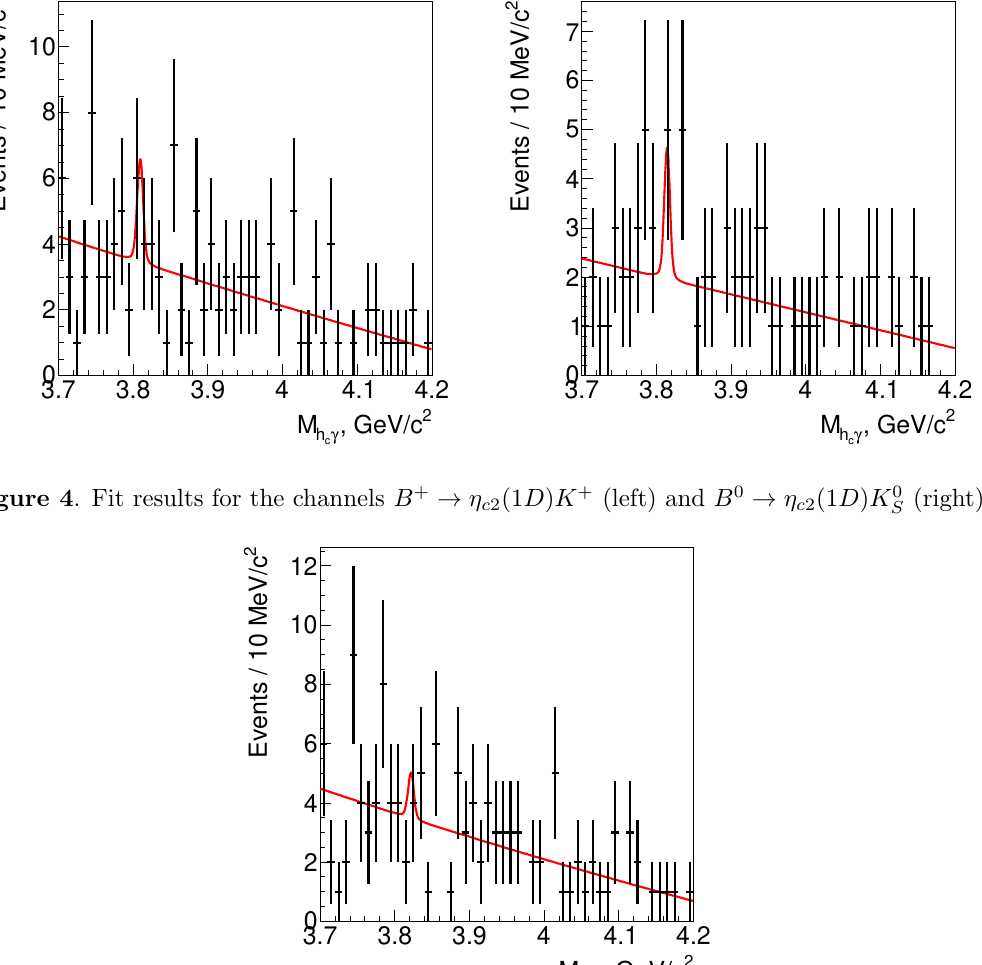
Figure 5 . Fit results for the combination of channels B +